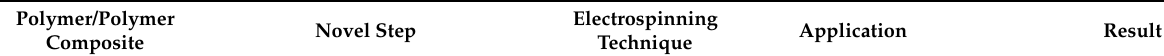
Table 2. Natural and synthetic polymers used for tissue engineering